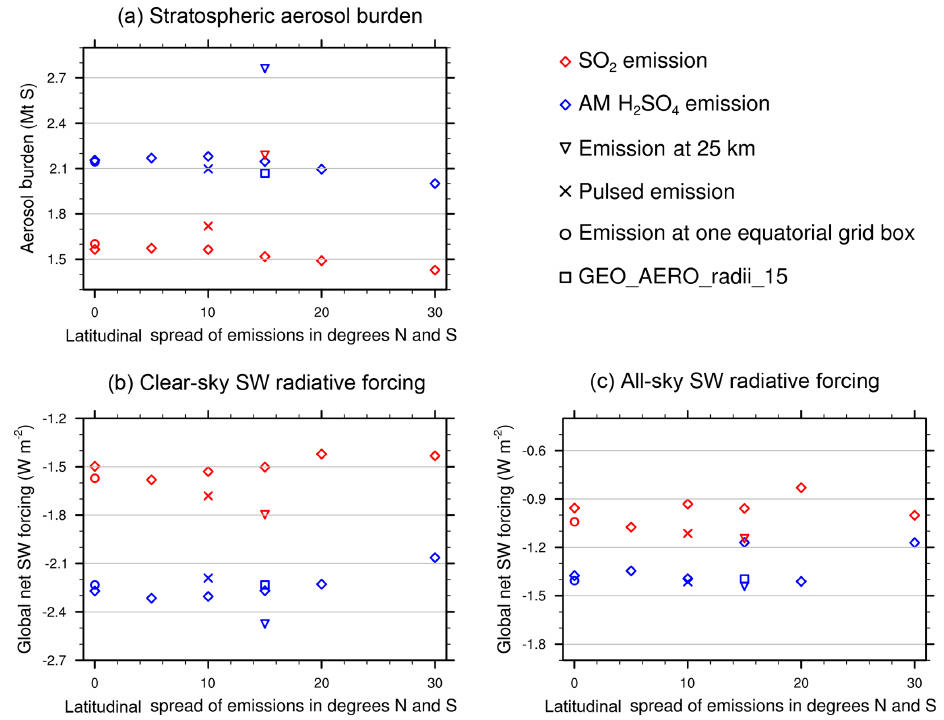
Figure 4. Globally averaged stratospheric aerosol burden (a) , clear-sky (b) and all-sky (c) SW surface radiative forcing for various scenarios simulated in this study. AM H 2 SO 4 emission scenarios are shown in blue and SO 2 emission scenarios are shown in red. Reference scenarios are shown using “diamond” symbols. Alternate cases are shown using the symbols indicated in